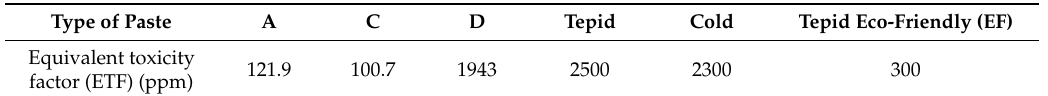
Table 4. Equivalent toxicity factor according to [2] for pastes A, C, and